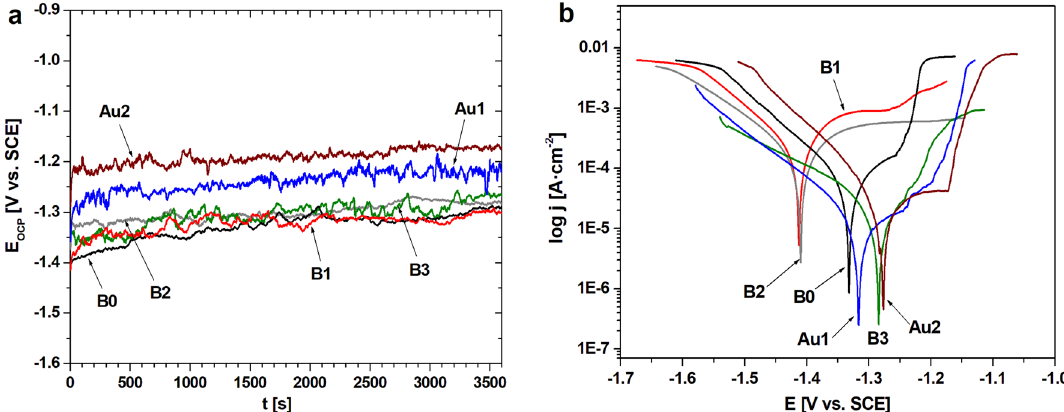
Figure 3. Changes of open-circuit potential with time ( a ) and polarization curves ( b ) of CaMgZnYbBAu alloys in a form of plates in PWE solution at 37 °C.